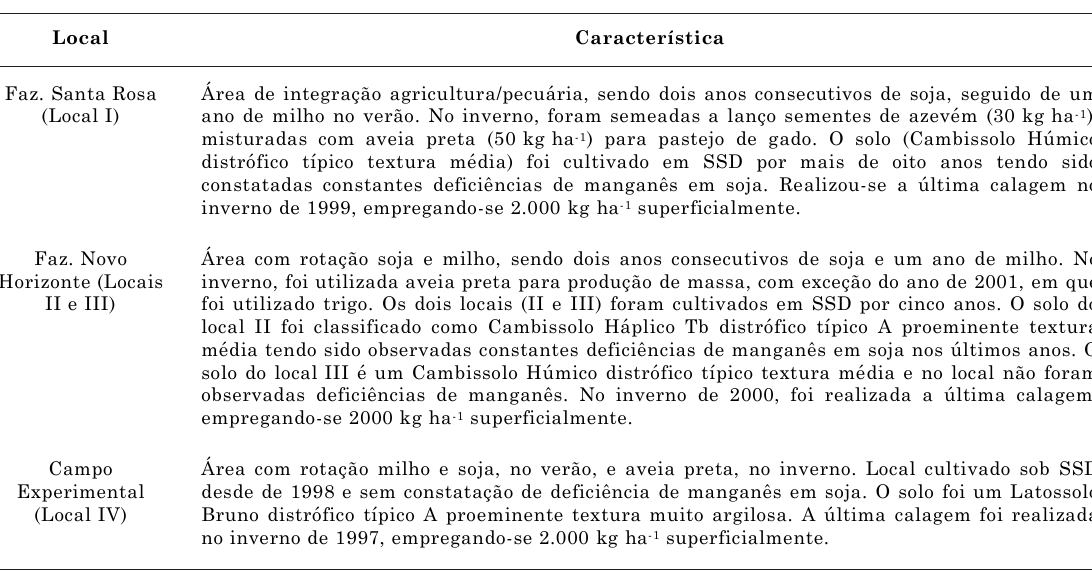
Zn). Cada experimento foi conduzido em delineamento experimental de blocos ao acaso (quatro blocos).